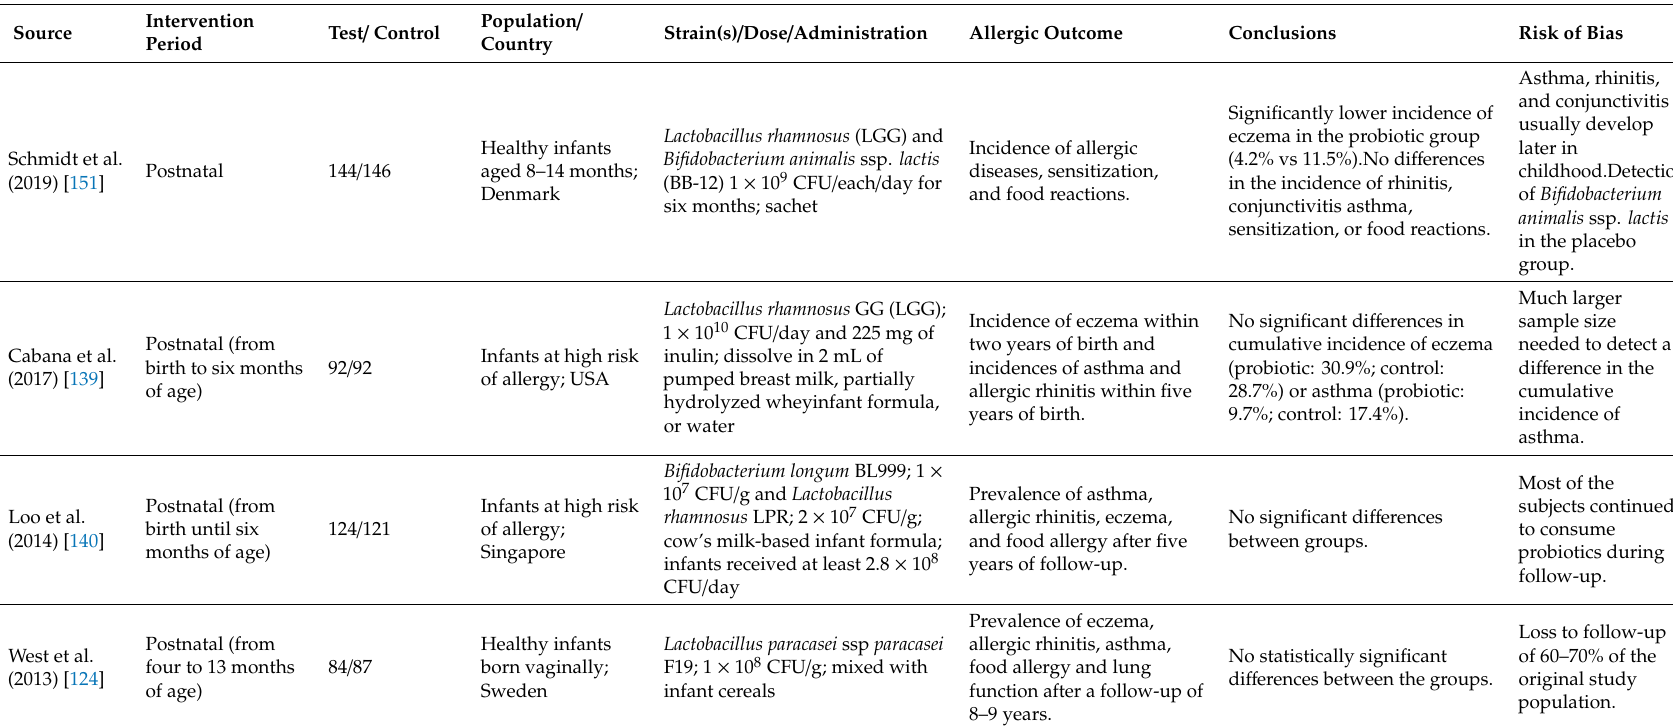
Table 5. Studies based on the use of probiotics during postnatal period for the prevention of asthma, wheezing, and